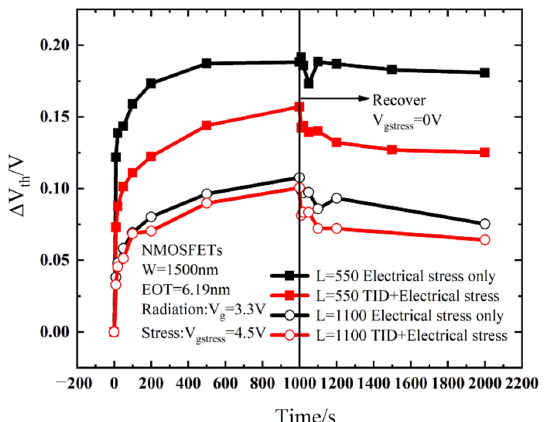
Figure 13. The relationship of threshold voltage shifts of devices with different gate lengths as a function of time.